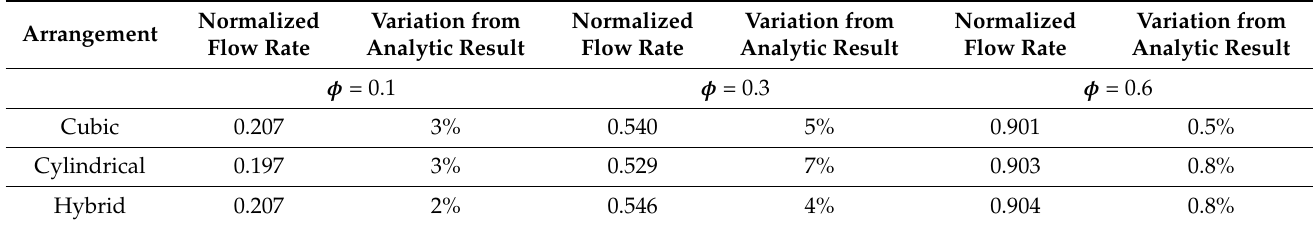
Table 2. Effect of particle arrangement in the SPH simulations.